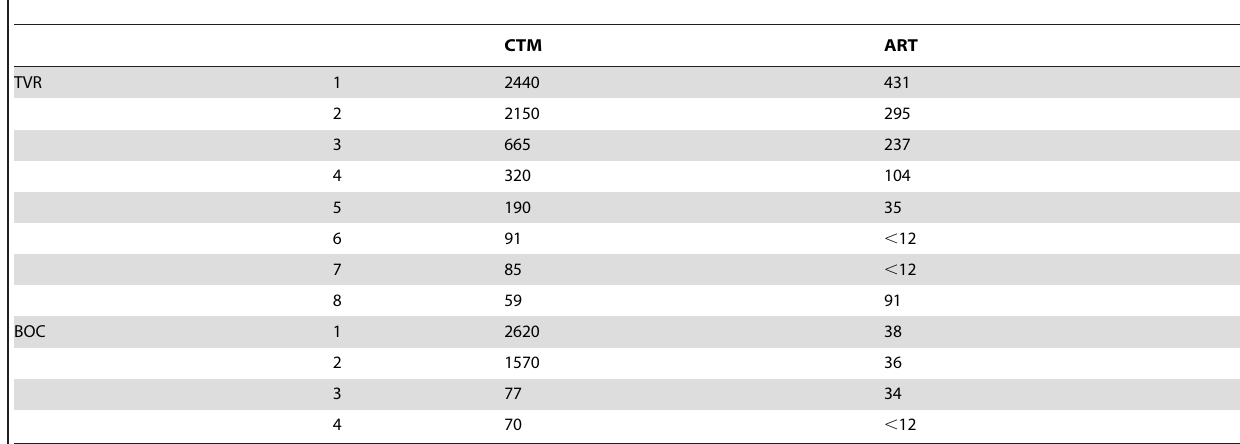
Table 2. HCV RNA levels according to ART and CTM in samples obtained 4 weeks after start of TVR/BOC therapy that yielded levels $ 50 IU/ml in at least one of the two